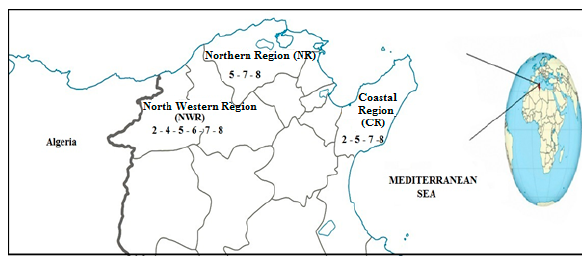
Figure 1. Races of Pyrenophora tritici-repentis characterized from durum wheat grown in three regions of Tunisia, North